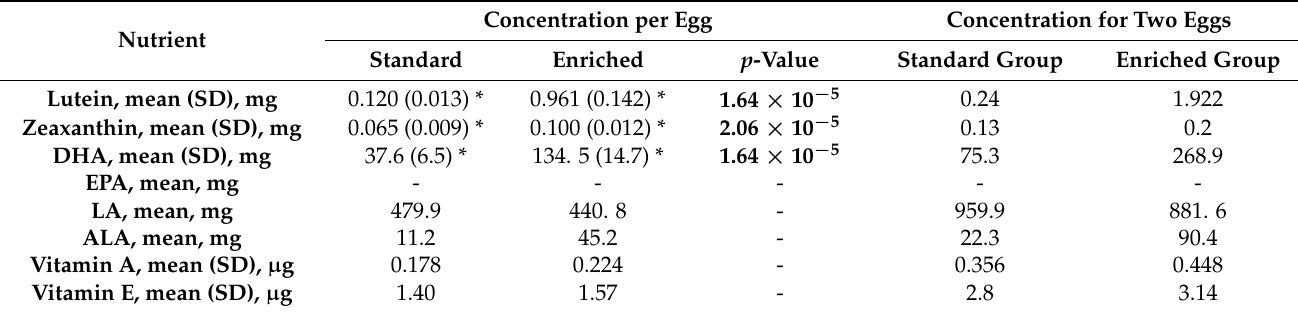
Table 1. Lutein, zeaxanthin, vitamin A, vitamin E, and polyunsaturated fatty acid contents of the eggs used in the study. Concentration per Egg Concentration for Two Eggs Nutrient Standard Enriched p -Value Standard